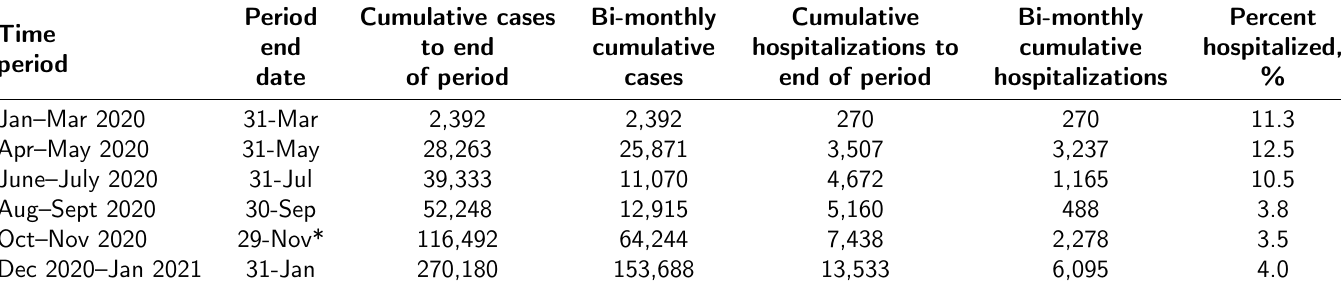
Table A2.4: Estimating the percentage of hospitalized COVID-19 cases in Ontario, Canada